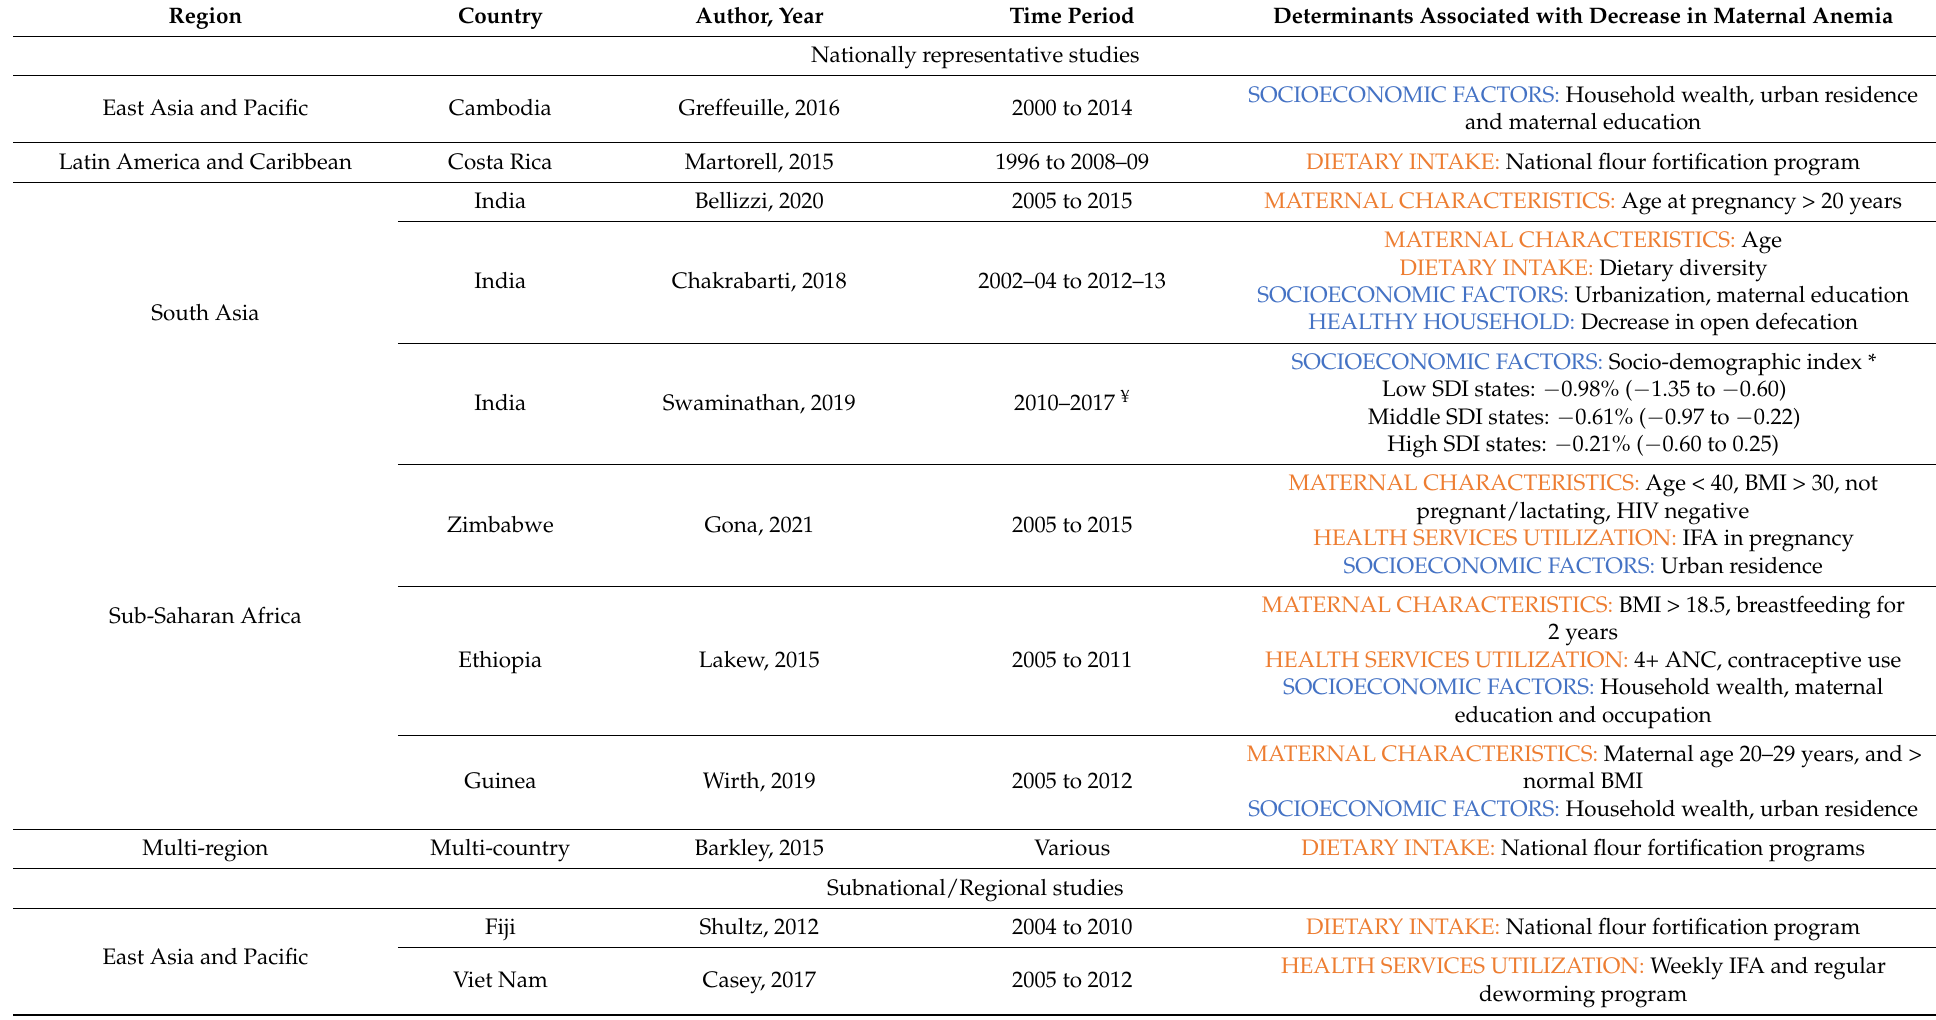
Table 2. Summary of determinants associated with anemia reduction among WRA, across regions and studies